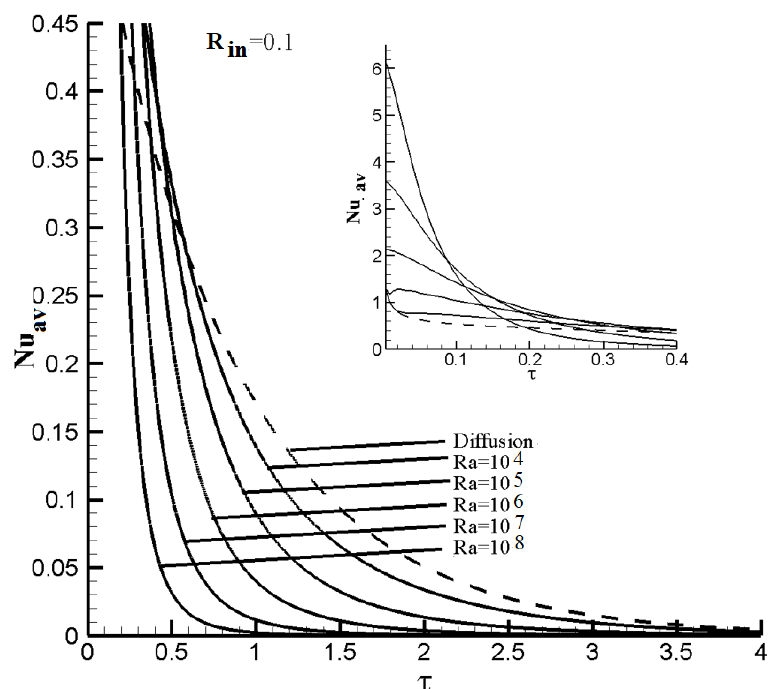
Figure 6. Nusselt number as a function of time for different Ra and for R in = 0.1.